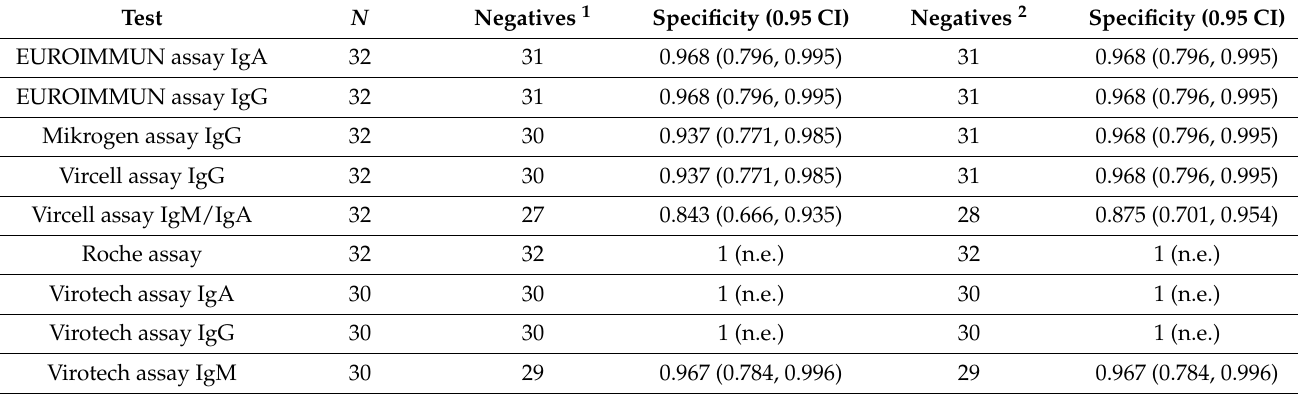
Table 4. Specificity of the test assays as calculated based on the sera from the Epstein–Barr virus (EBV) patients.